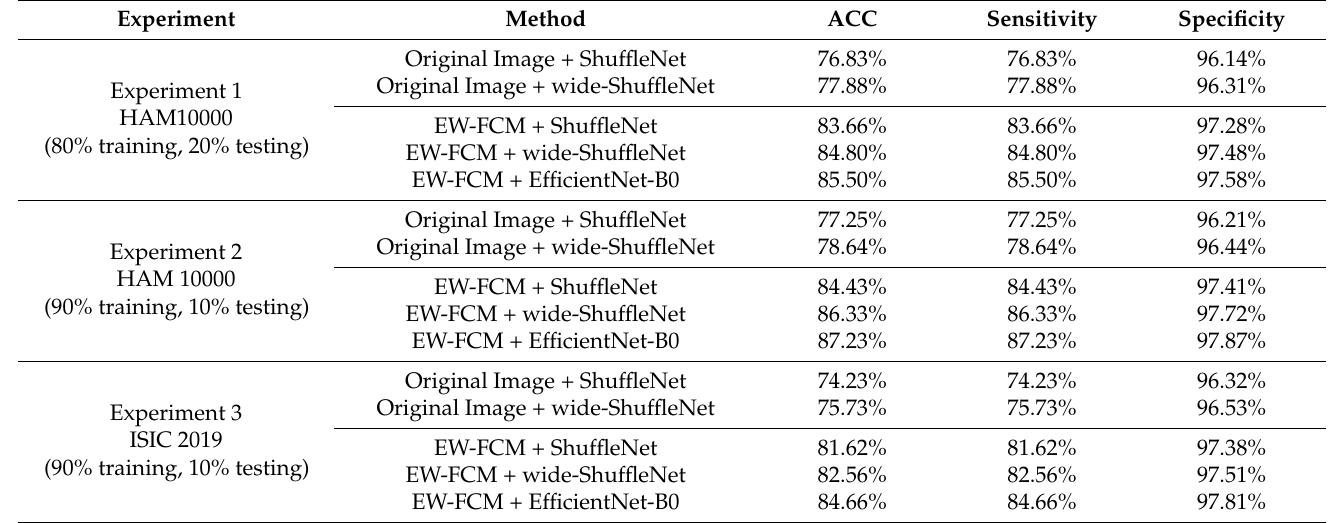
Table 8. Comparison with different networks on the HAM10000 and ISIC2019 datasets